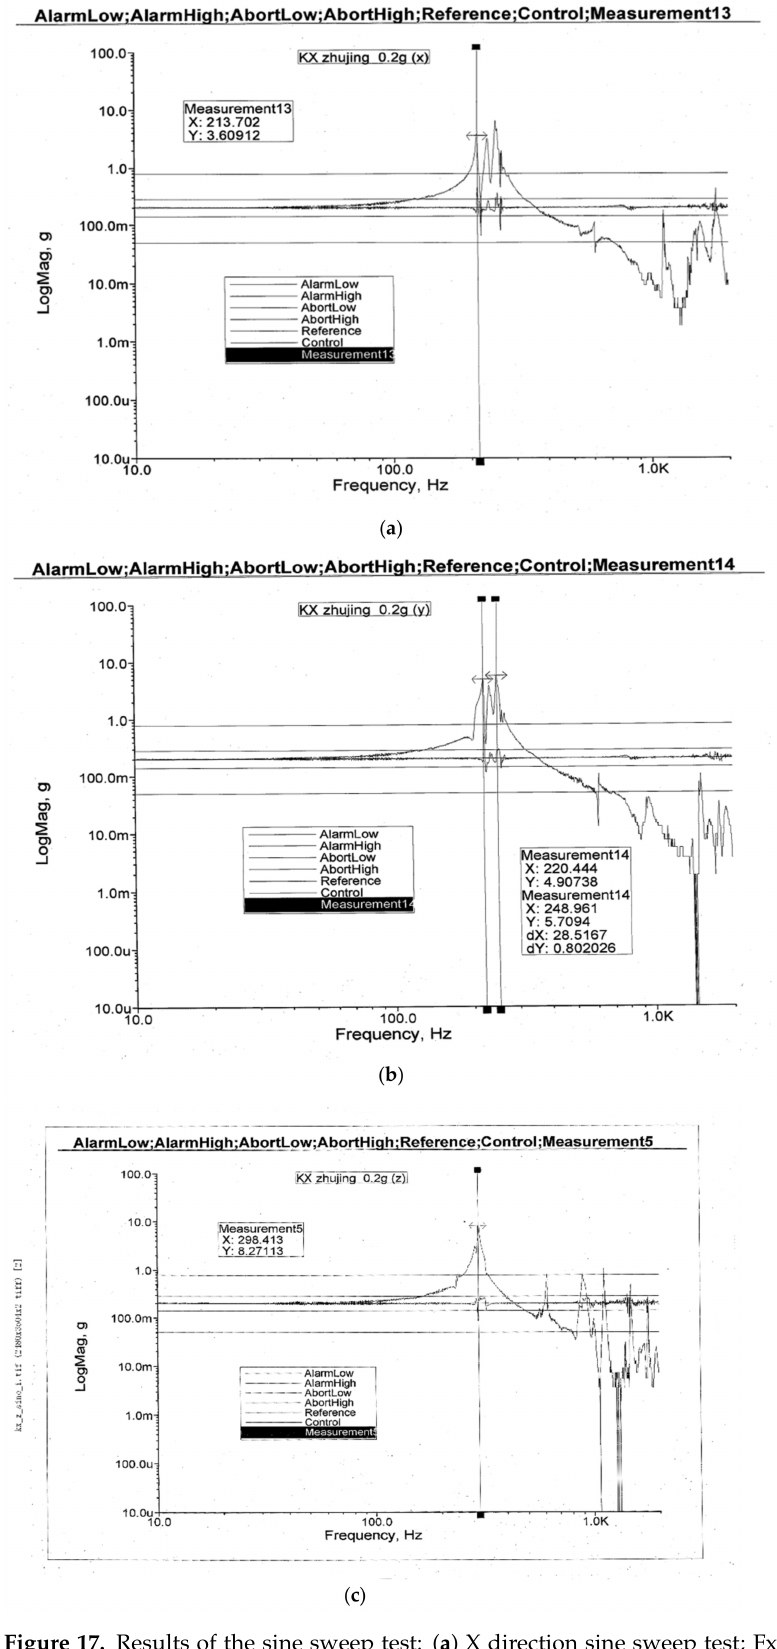
Figure 17. Results of the sine sweep test: ( a ) X direction sine sweep test; Fx = 213.702 Hz. ( b ) Y direction sine sweep test; Fy = 220.444 Hz. ( c ) Z direction sine sweep test; Fz = 298.413